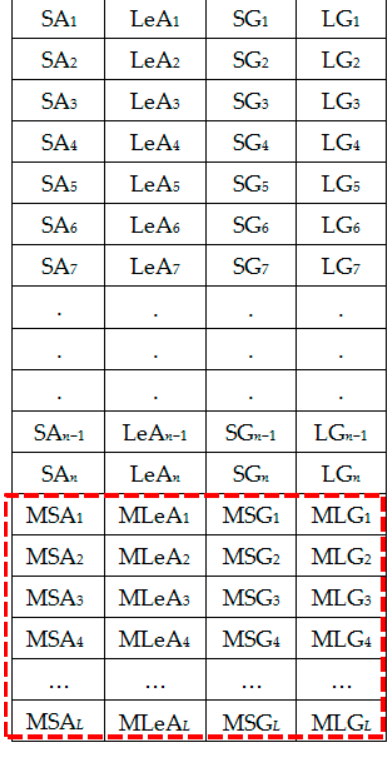
Figure 8. Set 2: OR + LA1 dataset.